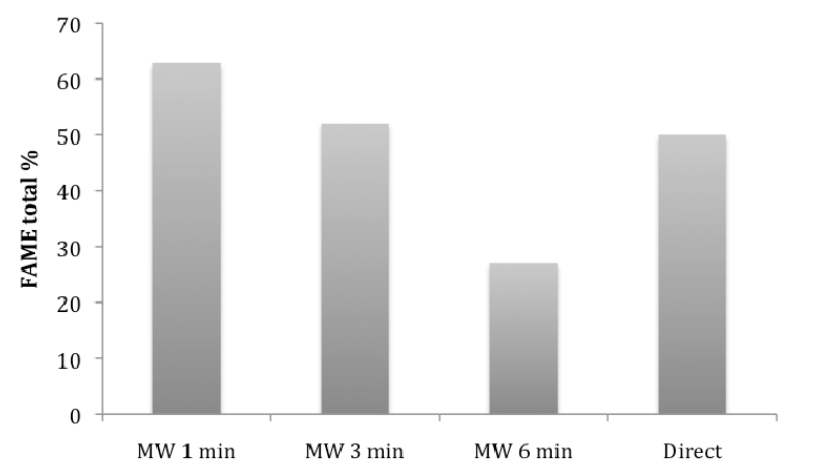
Figure 4. FAME yield of the sunflower oil using both